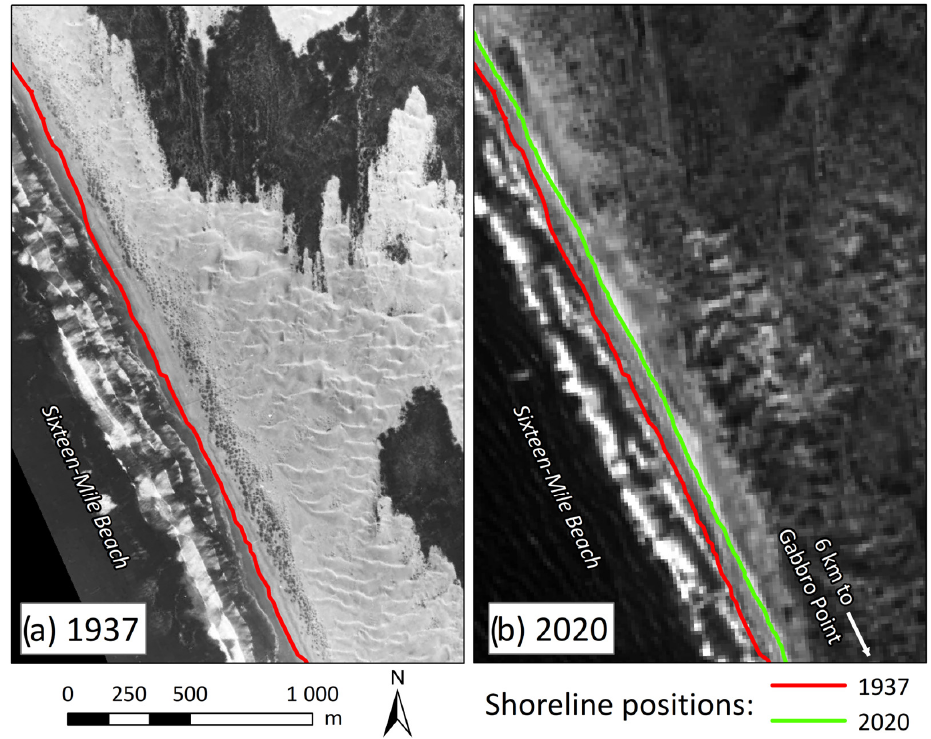
Figure 9. A comparison between ( a ) the historical aerial photograph from 1937 and ( b ) the panchromatic Landsat-8 image from 2020 showing the change in shoreline position and coastal dune distribution.